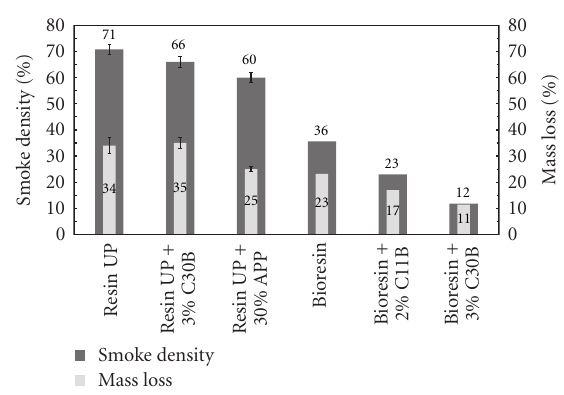
Figure 12: Results of the flammability tests carried out on various composite laminates made by SCRIMP